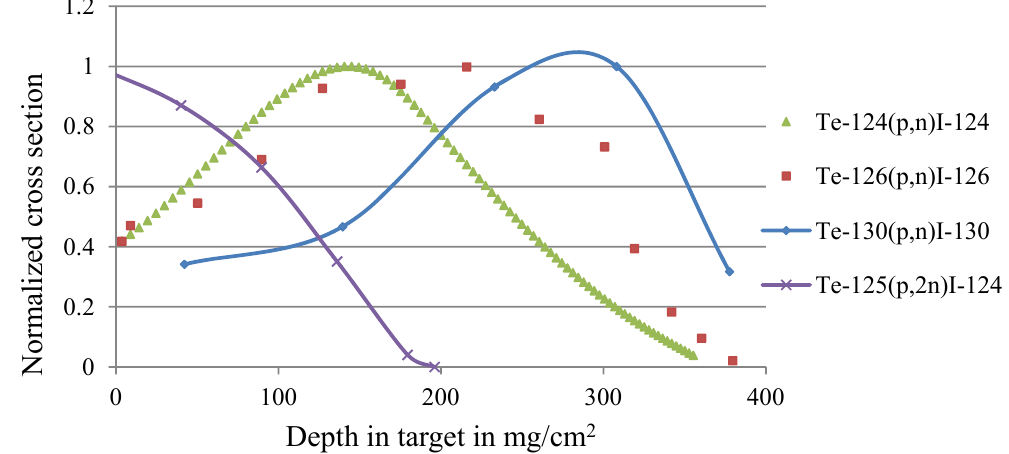
Figure 7. Using SRIM software by James F. Ziegler, the cross sections were converted from being a function of energy to being a function of depth in the target material, with a starting energy of 14.8 MeV. The cross sections have been summed and normalized to facilitate comparison of